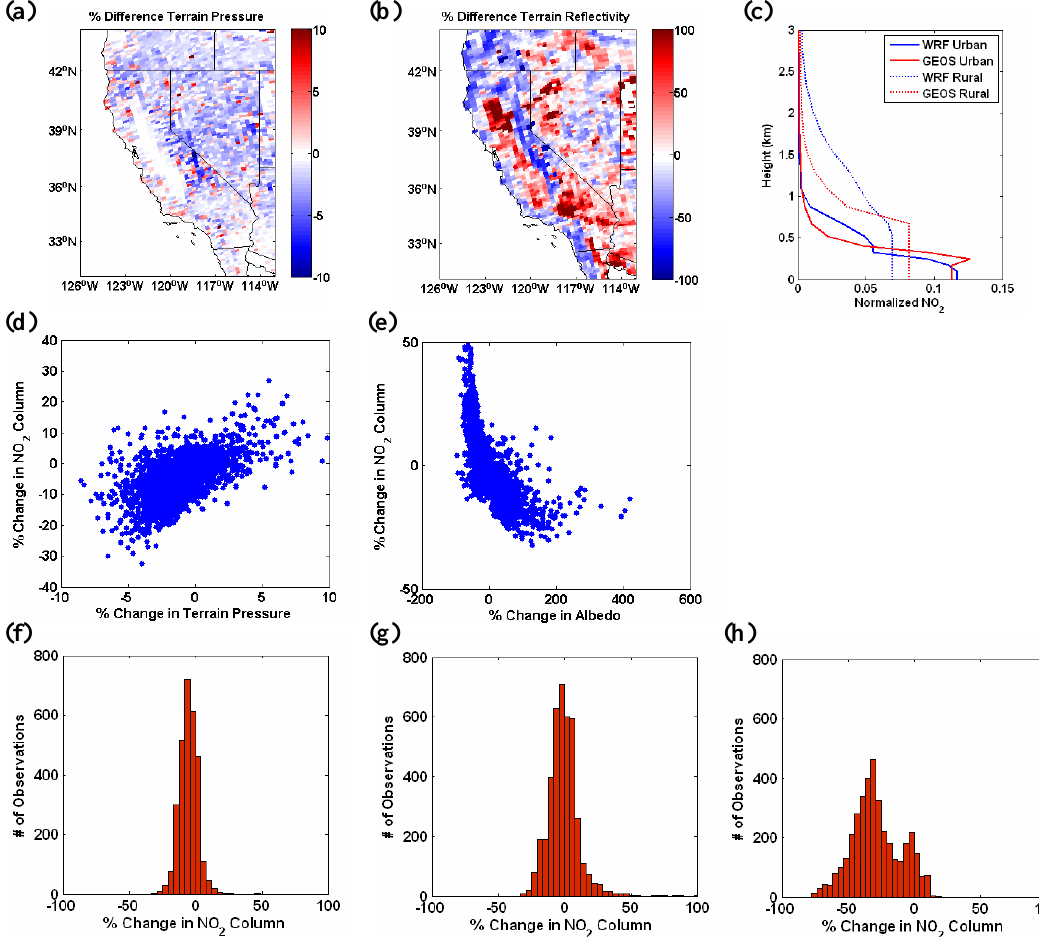
Fig. 1. Retrieval inputs from the BEHR retrieval are compared with those from the Standard Product. Maps of the percent change in (a) terrain pressure and (b) and terrain reflectivity for 18 June 2008. (c) Profile shapes from GEOS-Chem and WRF-Chem for single points over urban and rural regions in California. The percent change in NO 2 column versus the percent change in (d) terrain pressure and (e) albedo. Histograms of the percent change in NO 2 column due to changes in (f) terrain pressure, (g) albedo, and (h) NO 2 profile